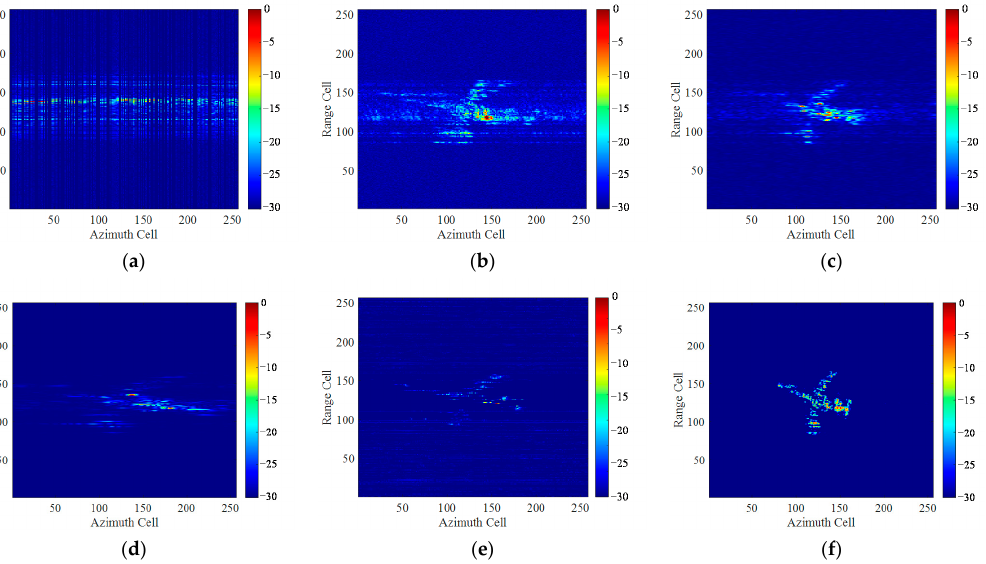
Figure 20. Imaging results of Yak-42 under 50% sampling ratio with SNR = 0 dB by different methods: ( a ) echo after translational motion compensation; ( b ) RD algorithm; ( c ) STFT algorithm; ( d ) SPWVD algorithm; ( e ) RWT algorithm; ( f ) The proposed method.